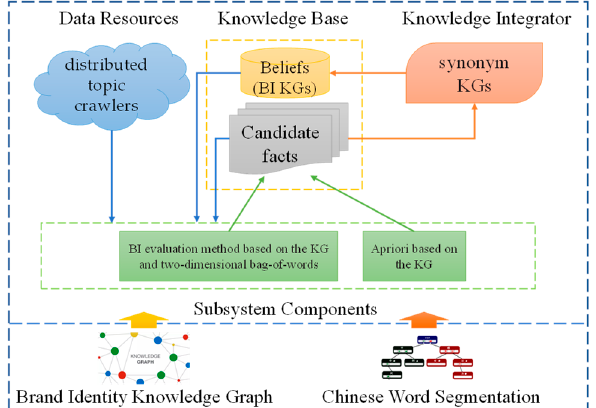
Figure 2. Never-Ending Language Learning model for Chinese Brand Identity Management. Figure 2. Never‑Ending Language Learning model for Chinese Brand Identity Management.